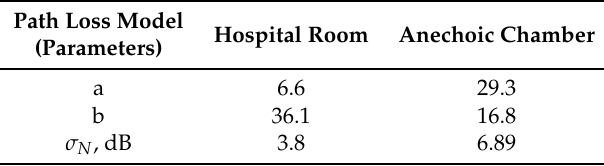
Table 5. Channel model for the narrow band ( i.e. ,